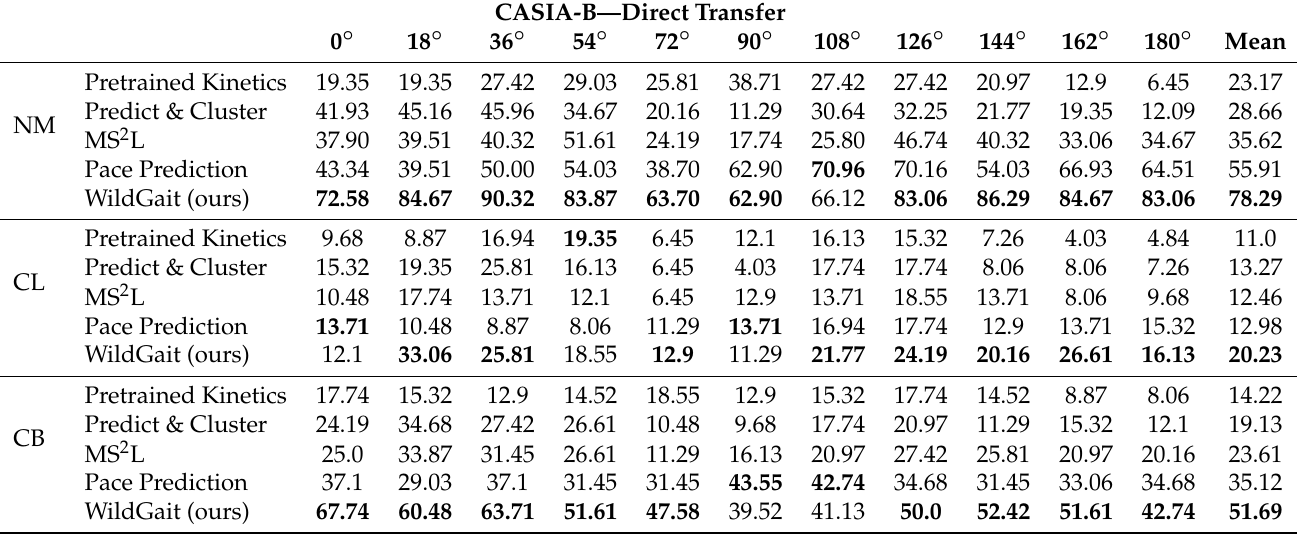
Table 3. Transfer learning comparison with other unsupervised skeleton-based training methods on CASIA-B. WildGait consistently outperforms standard methods for unsupervised learning from skeleton sequences. We report accuracy where the gallery set contains all viewpoints except the probe angle (top row). We highlight with bold our method (WildGait) and best results in each walking variation.